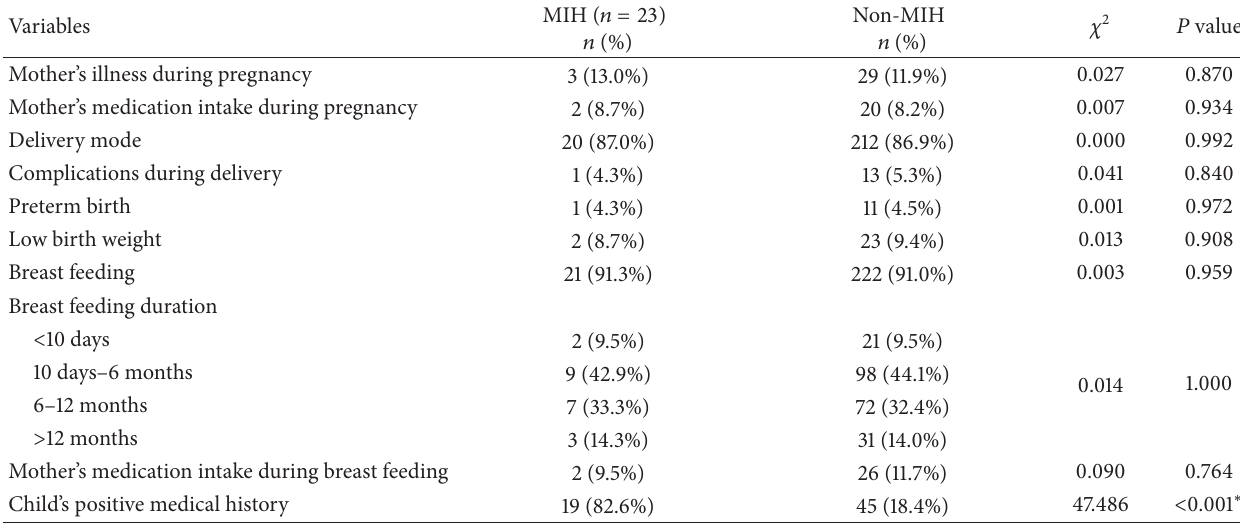
Table 6: The association between mother’s medical history, delivery complications, breast feeding, and prevalence of MIH.